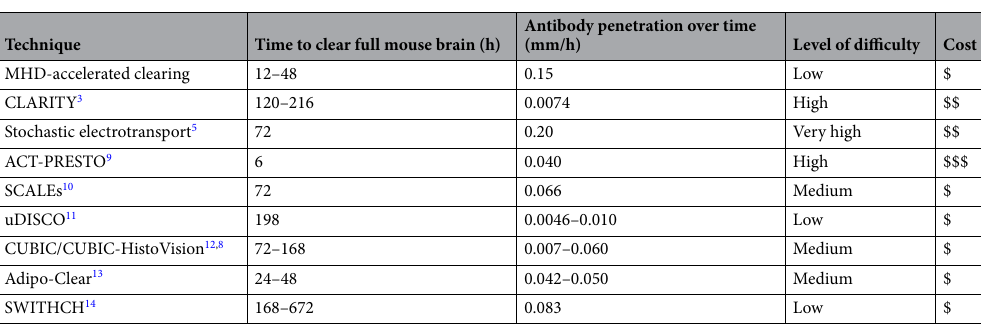
Table 1. A direct comparison of multiple popular clearing techniques, based on literature, that shows the reported time it takes to clear an intact mouse brain, the relative antibody penetration into the tissue over a single hour, the degree of difficulty to setup and use the technique, and the amount of money it costs to implement the technique effectively. Degree of difficulty is a subjective measure of the amount and complexity of steps and solutions required to implement each technique and the level of expertise required construct devices for required for the technique and use these devices to clear mouse tissue. Level of difficulty ranges from easy (easy setup and/or requiring very few easy steps) to very hard (intricate setup that requires a high level of specialized expertise and/or requires many difficult steps) Cost to implement the technique is displayed as less than $1000 ($), less than $10,000 ($$), and over $10,000